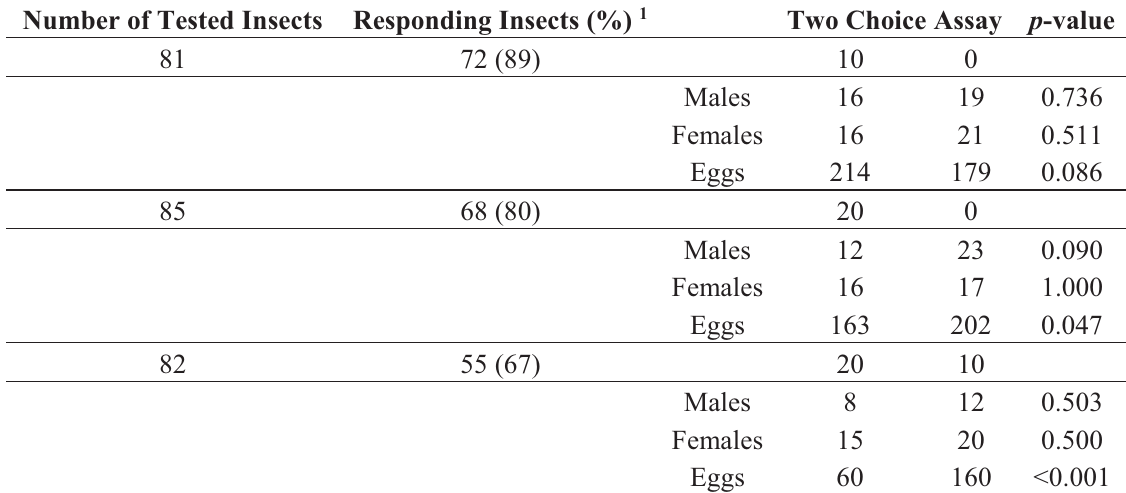
Table 1. Results of dual choice bio-assays evaluating the preference of T. absoluta for non-infested, 10 larvae-infested and 20 larvae-infested tomato plants. The number of adult males and females, and eggs laid by females, was assessed in each zone/plant of the flying tunnel (0 = non-infested plant area, 10 = 10 larvae-infested plant area, 20 = 20 larvae-infested plant area). Values are total numbers of individuals for each combination (four